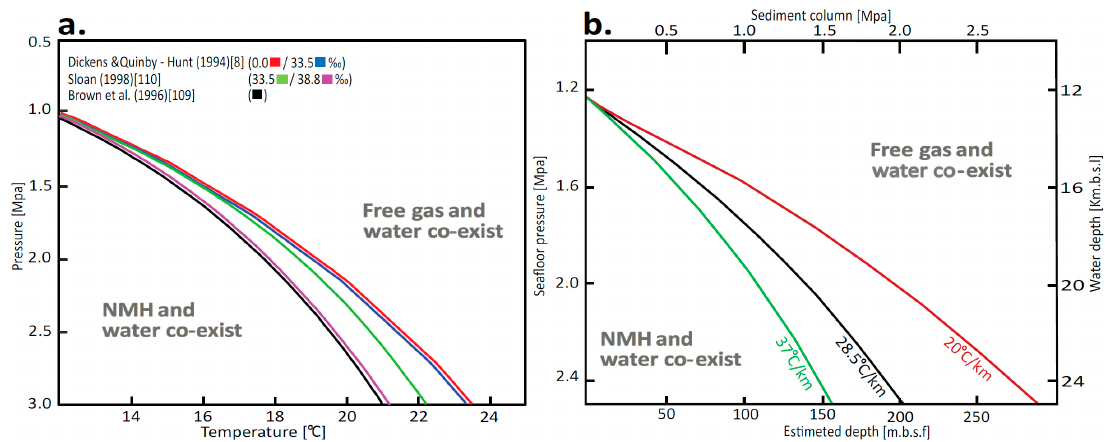
Figure 3. A comparison of modeled methane hydrate stability curves. ( a ) The equilibrium curves predicted by the different modeling schemes considered in this work [8,109,110] under different constant salinity conditions (as color ‐ coded at the top). ( b ) The effect of different temperature gradients (color ‐ coded as noted) on the depth below the seafloor of the base gas hydrate stability zone (GHSZ) predicted by CSMhyd [89] with a constant salinity of 38.8‰, as a function of the seafloor water depth.